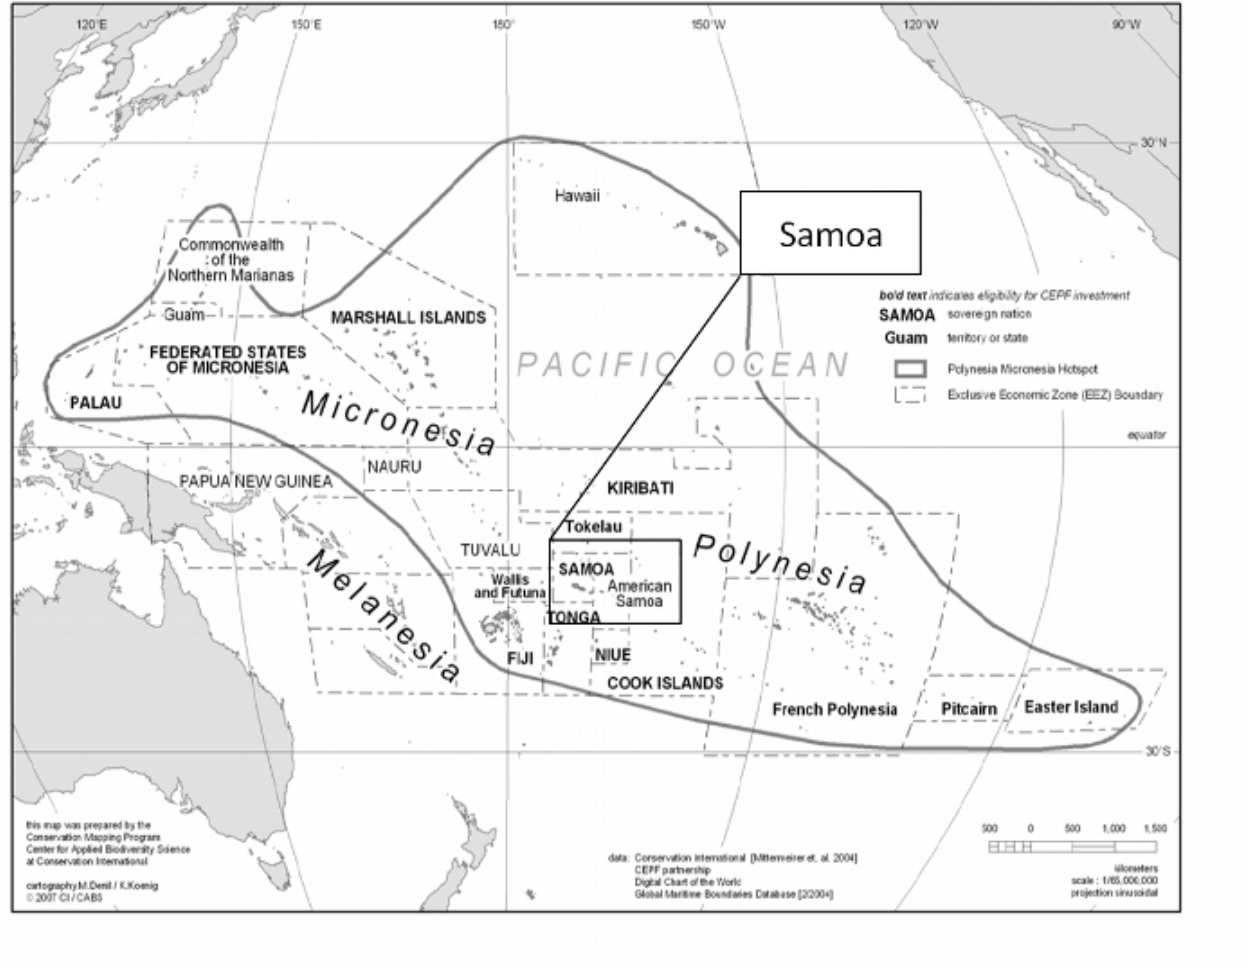
Fig. 1. Polynesia-Micronesia hot spot with Samoa highlighted in box (Conservation International